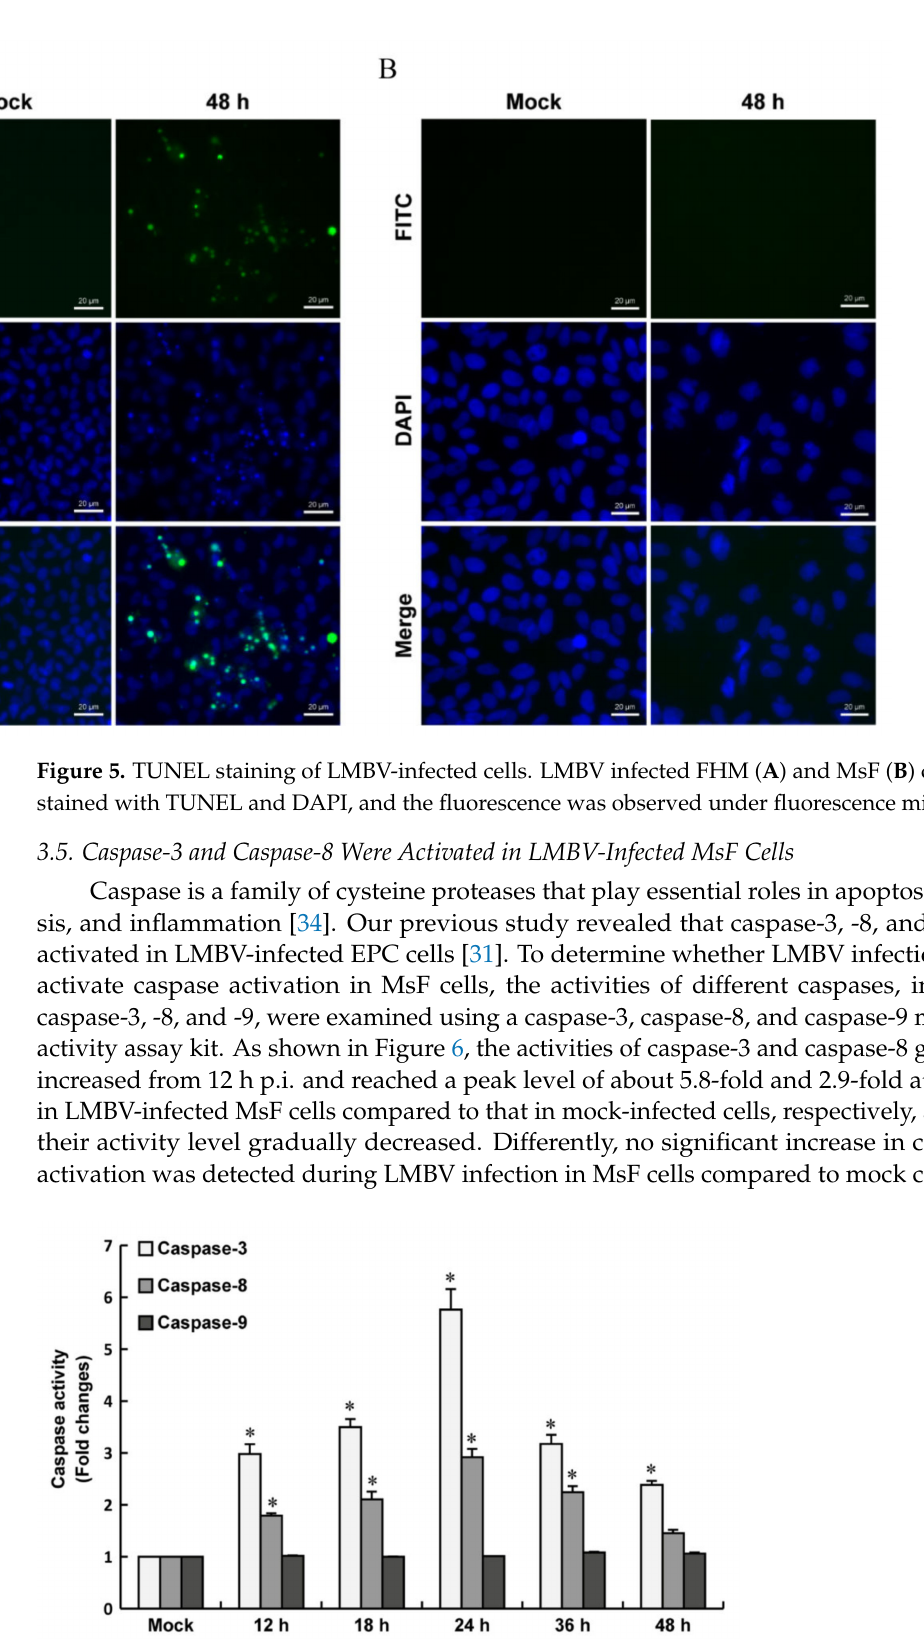
Figure 6. Caspase activation by LMBV infection in MsF cells. The activities of caspase-3, -8, and -9 were examined in LMBV-infected MsF cells using a caspase-3, caspase-8, and caspase-9 multiplex activity assay kit. * indicates p <